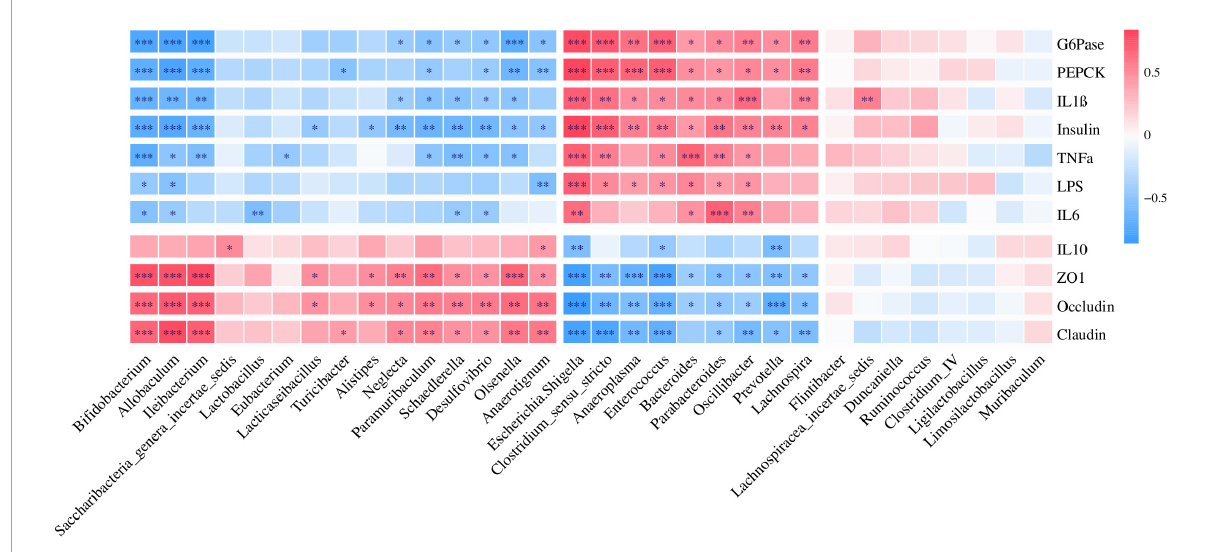
FIGURE6 Correlations analysis between the genus level of gut microbiota and parameters related to glucose metabolism, cytokines, and colonic tight junction protein.